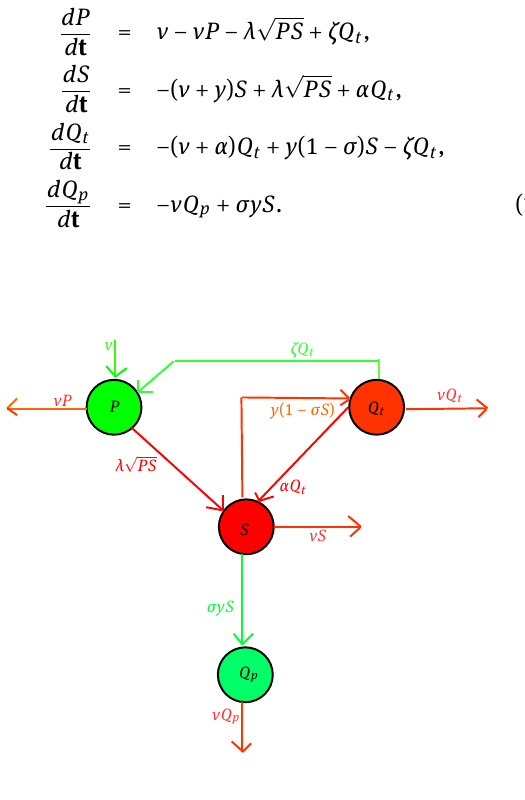
Figure 1: Schematic flow diagram for